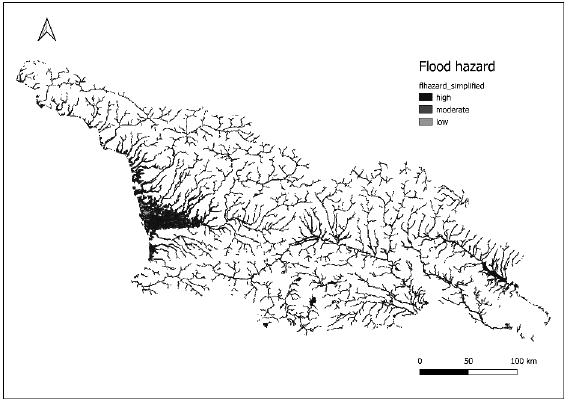
Figure 6. Flood hazard (CENN, 2018)